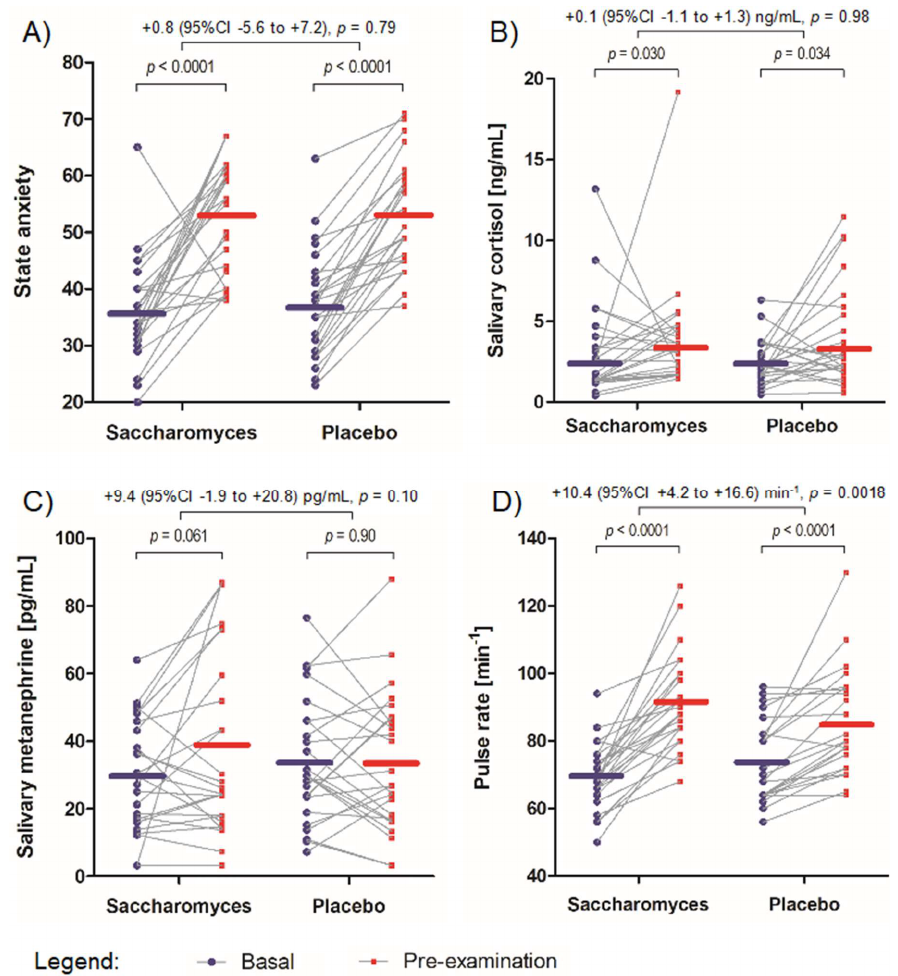
Figure 4. Secondary outcome measures: Individual data points are marked and linked with a grey line between “basal” and “preexamination” time points. The mean scores are represented by horizontal lines for both “basal” and “preexamination” settings. The effect size of the differences between the increase in the measures together with p -values for the comparisons are reported above the graph. ( A ) The extent of increase in state anxiety between the study groups. ( B ) The extent of increase in salivary cortisol level between the study groups. ( C ) The extent of increase in salivary metanephrine level between the study groups. ( D ) The extent of increase in pulse rate between the study groups.